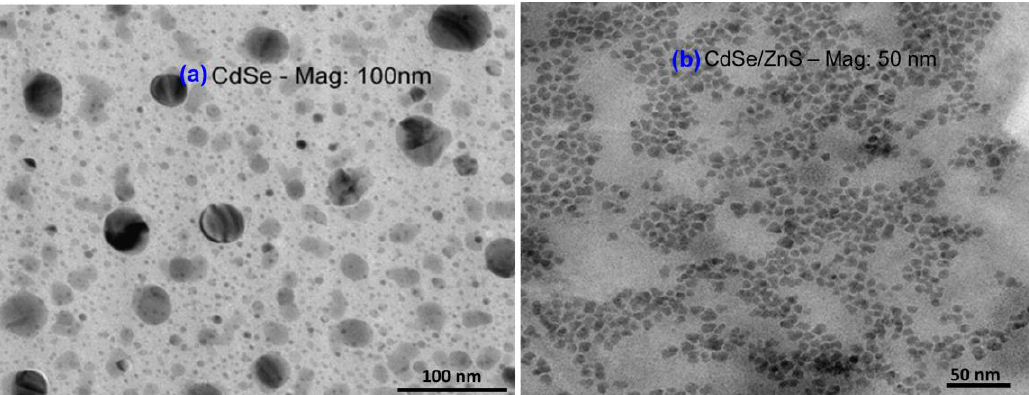
Figure 2. TEM results of ( a ) CdSe core, and ( b ) CdSe/ZnS core-shell QDs with the magnifications of 100 nm and 50 nm, respectively.